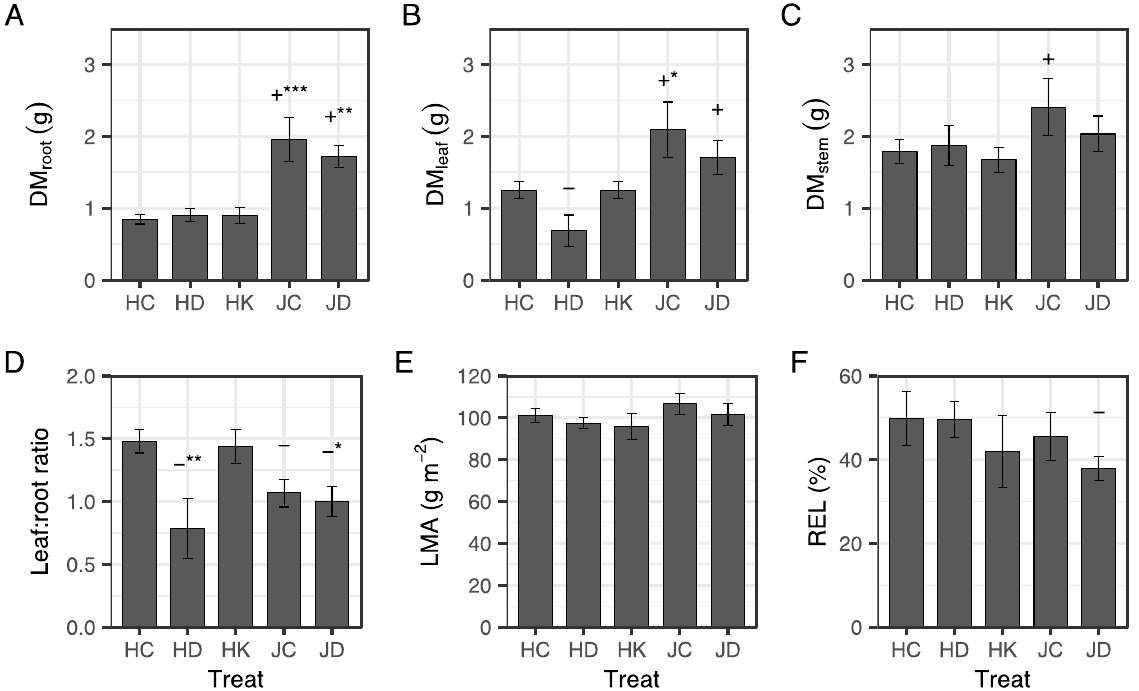
Figure 1. Mean values ± standard error (SE; n = 5) for dry mass parameters and relative electrolyte leakage from fine roots (REL) of container seedlings grown in Hiko-V-120 (H) and JFA-150 (J) containers with control irrigation and fertilization (HC and JC), dry irrigation (HD and JD), and high-potassium fertilization (HK). ( A ) DM root , dry mass of a root; ( B ) DM leaf , dry mass of a leaf; ( C ) DM stem , dry mass of a stem with a branch; ( D ) leaf:root ratio; ( E ) LMA, leaf dry mass per area; ( F ) REL. The plus or minus signs indicate a positive or negative effect, respectively, compared with the HC treatment in the linear model. * p < 0.05, ** p < 0.01, and *** p < 0.001.